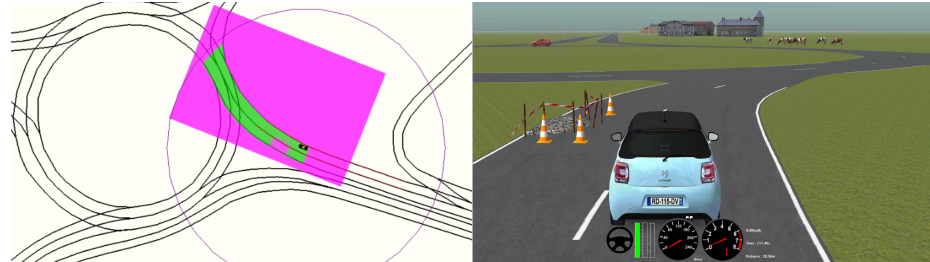
Figure 3. Occupancy grid for planning.